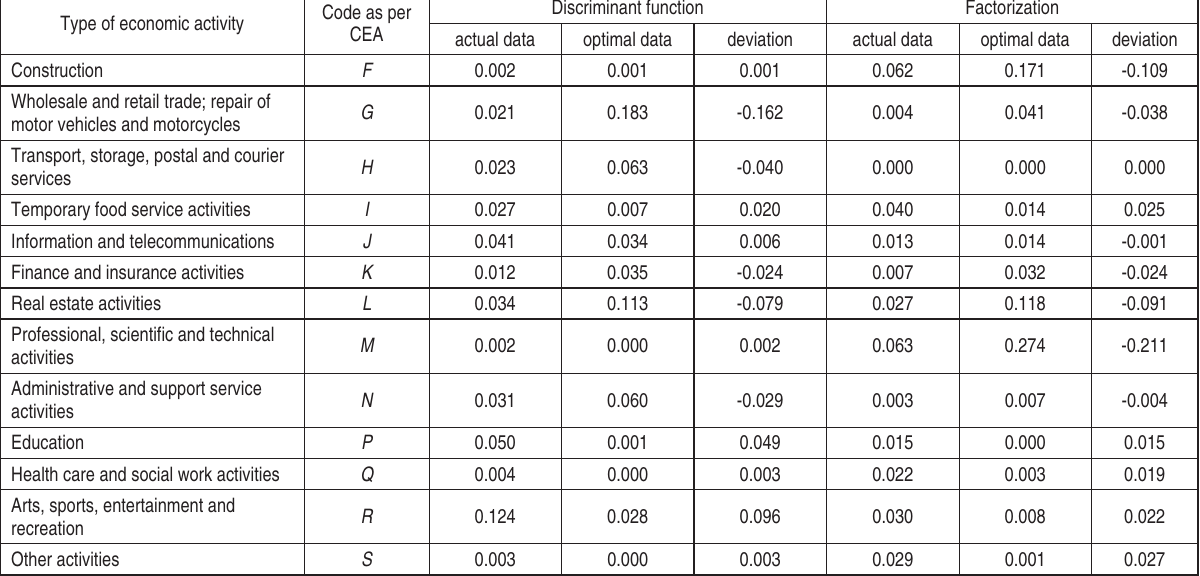
Table 6 (cont.). Optimal structured credit portfolio developed on the basis of assessing the creditworthiness